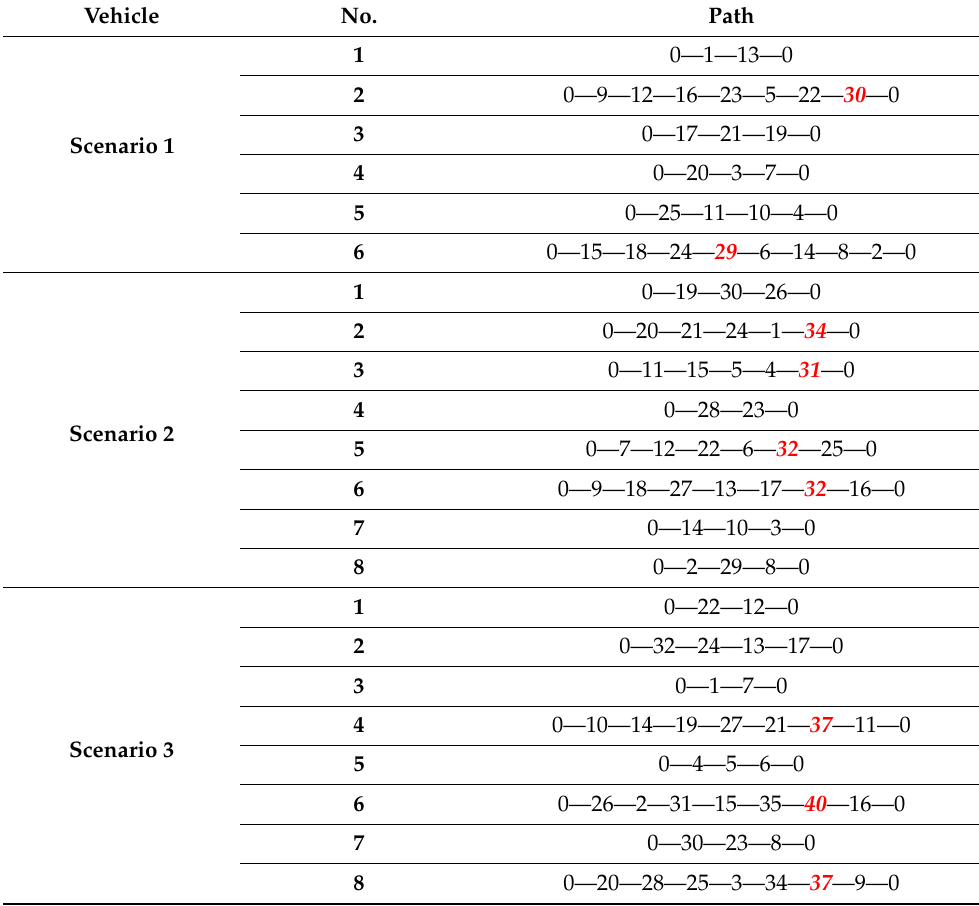
Table 13. Optimal delivery paths for